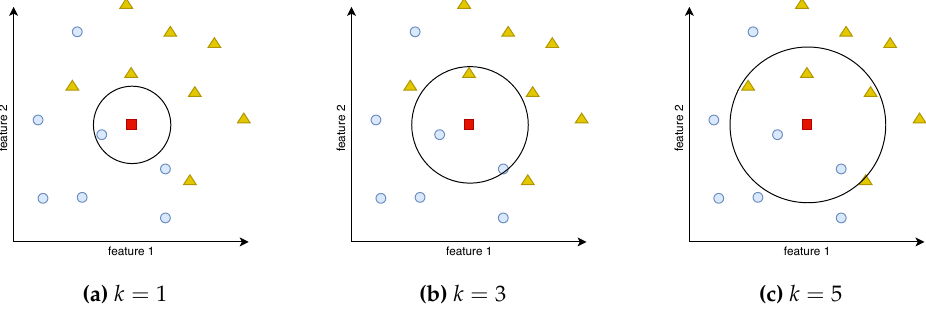
Figure 1. k-Nearest Neighbors—visualization of the closest data points for different k